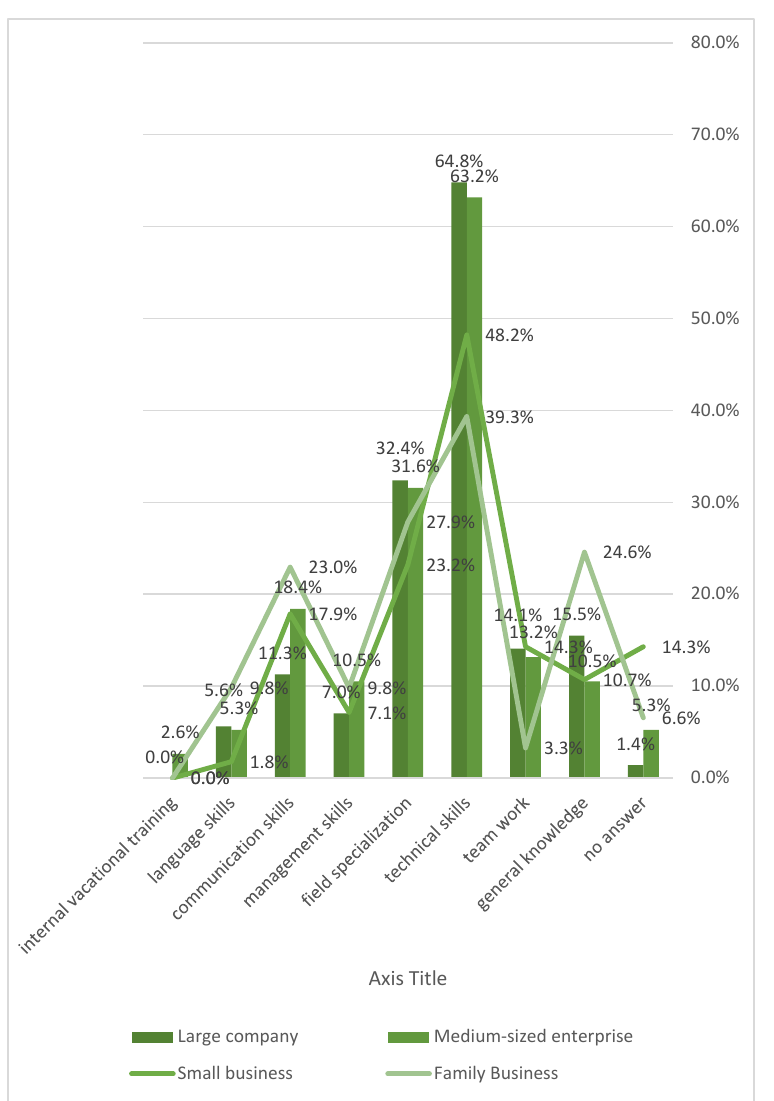
Figure 7. Education focus with respect to Industry 4.0.